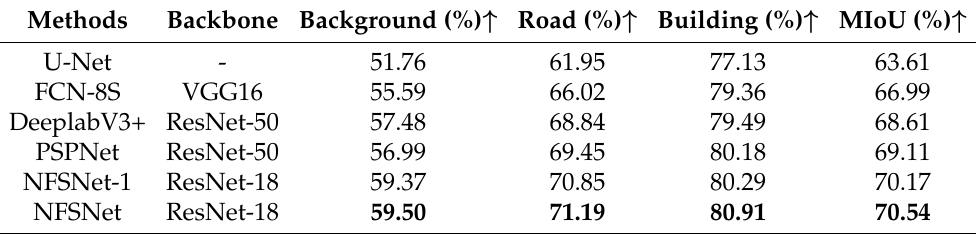
Table 2. Potsdam-A test set category IoU results. The highest values for the different metrics are highlighted in bold, ↑ means the higher the